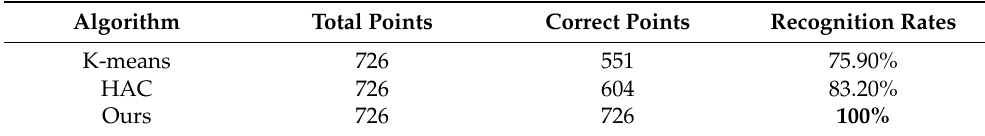
Figure 7. Results scattered point diagram and iteration change diagram. ( a ) FCM algorithm in a 2D scatter plot ( b ) FCM target function J iteration change diagram. Table 2. Three different algorithm cluster results